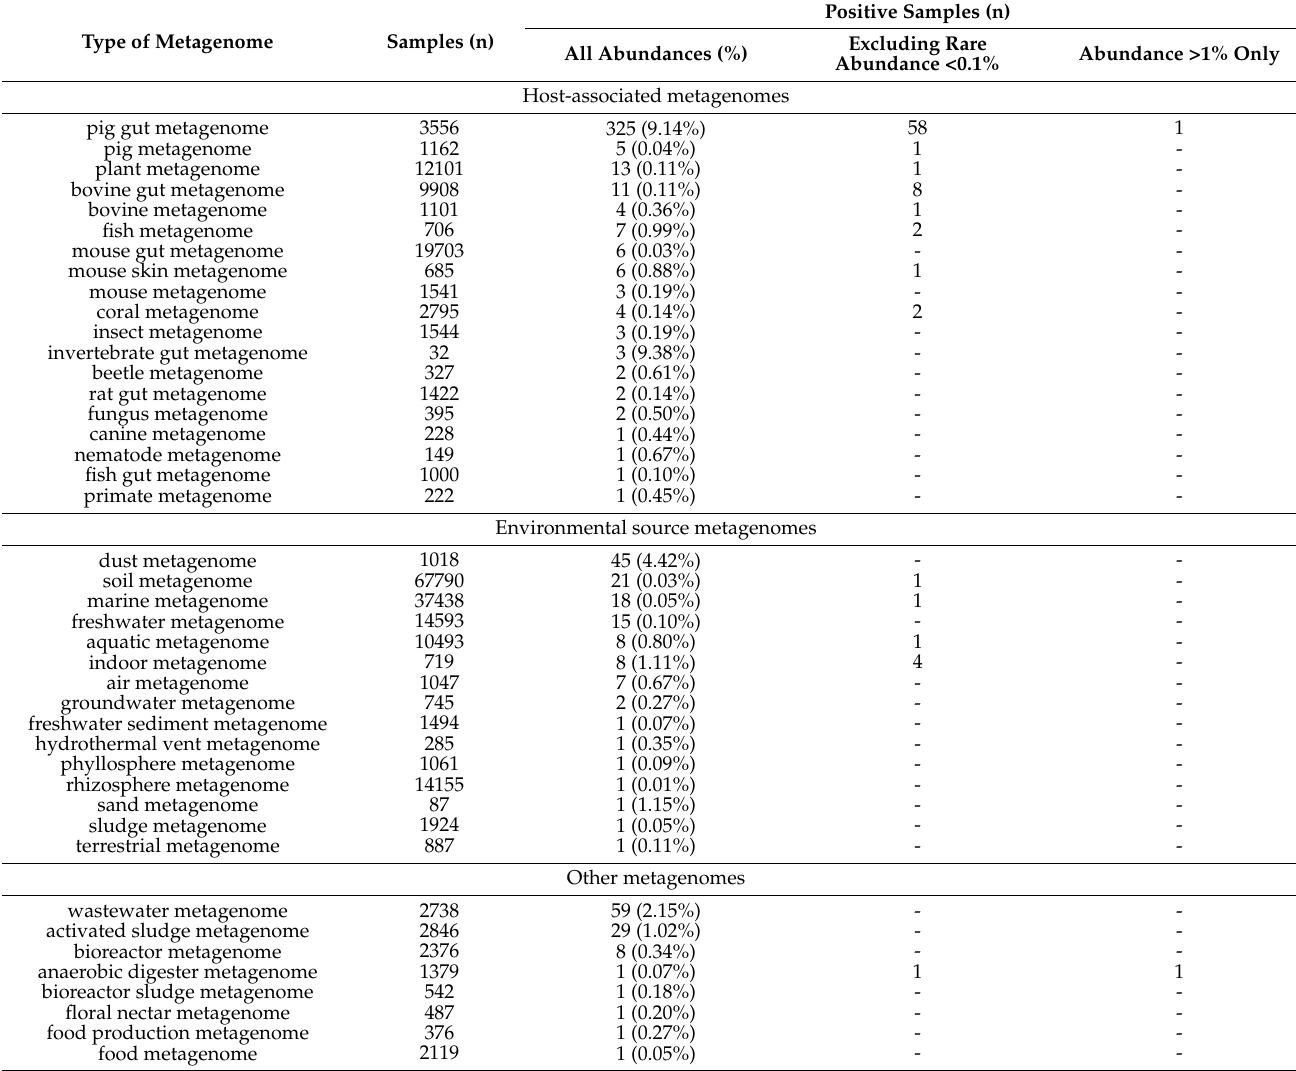
Table 2. Non-human metagenomes containing S. moorei